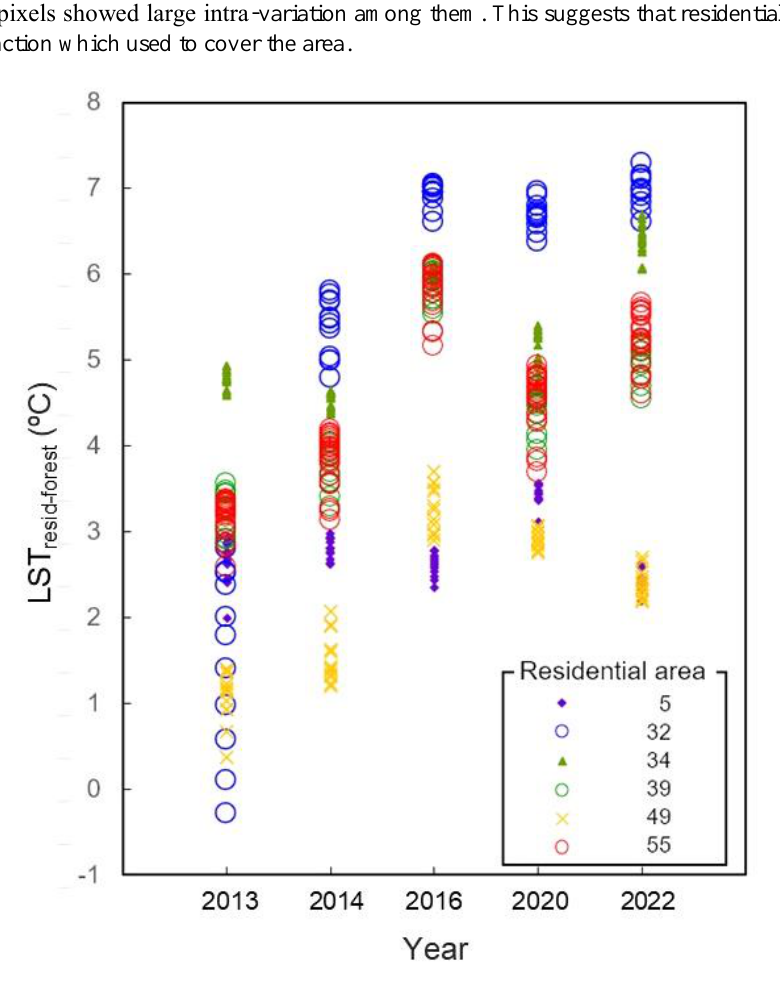
Figure 9. Changes in LST resid-forest (°C) for six residential areas completed between 2005 and